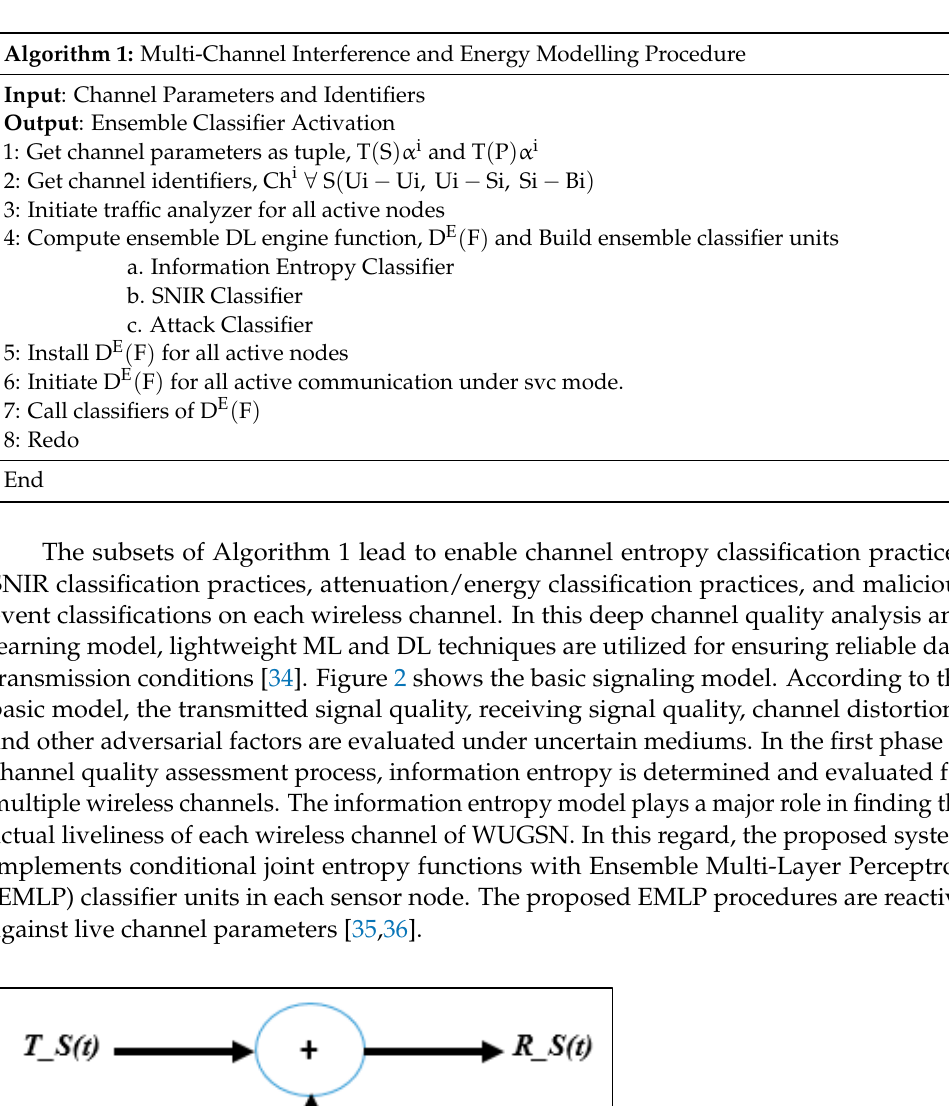
Algorithm 2: EMLP for Entropy Learning and